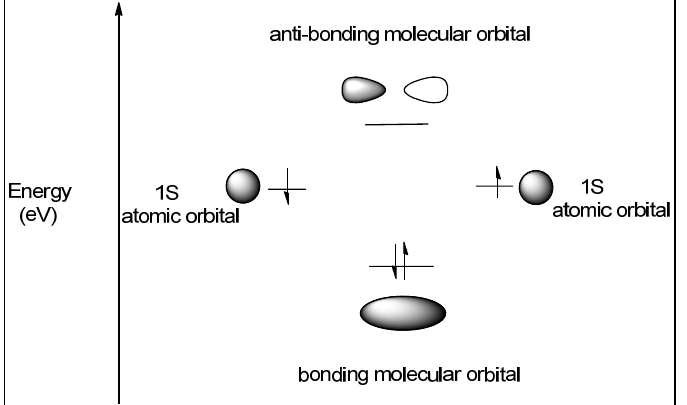
Figure 1. Molecular orbital energy levels diagram demonstrating the formation of σ -bonding and σ ̽ -antibonding molecular orbitals.